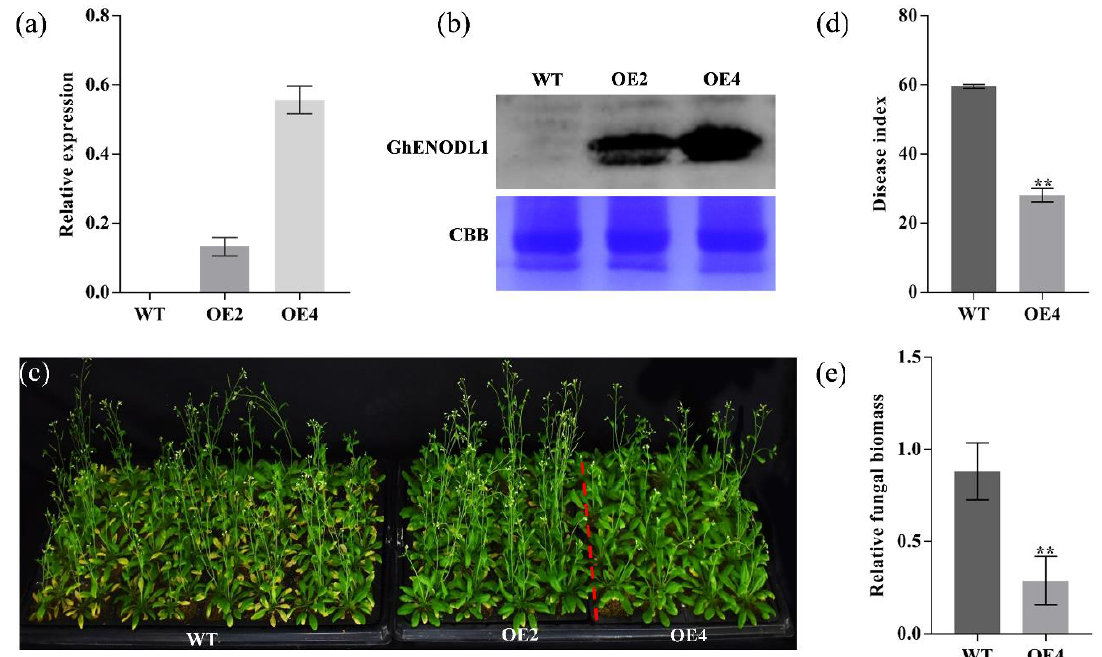
Figure 5. Overexpression of GhENODL6 in Arabidopsis improved resistance to V. dahliae . ( a ) Relative expression levels of GhENODL6 in different Arabidopsis strains. ( b ) Western blot result of GhENODL6 in transgenic lines and WT. The membranes were stained with Coomassie brilliant blue (CBB) as loading control. ( c ) Disease manifestations and diseased plants of wild-type and two homozygous transgenic plants (OE2, OE4) at 25 dpi. ( d ) Disease index of different strains at 25 dpi. ( e ) Relative expression levels of plant fungus biomass at 10 dpi. Error bars represent the SD of three biological replicates. Asterisks indicate statistically significant differences by Student’s t -test (two-tailed) (**, p < 0.01). All experiments were repeated at least three times.